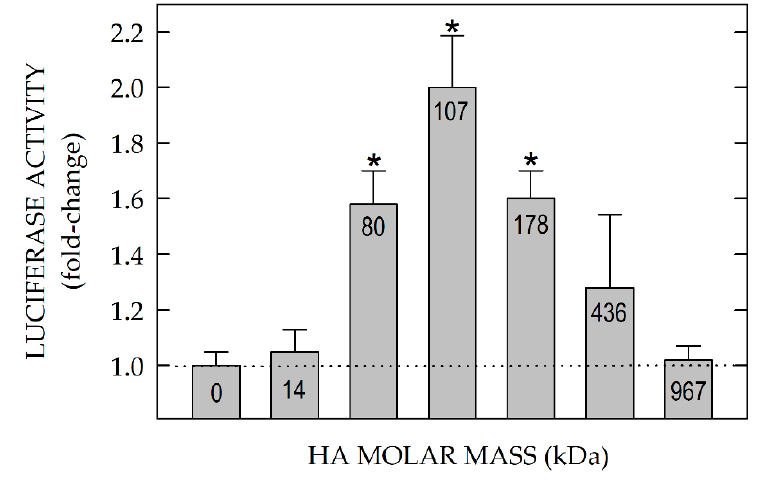
Figure 7. Cell signaling in response to HARE-mediated HA endocytosis is highly dependent on HA